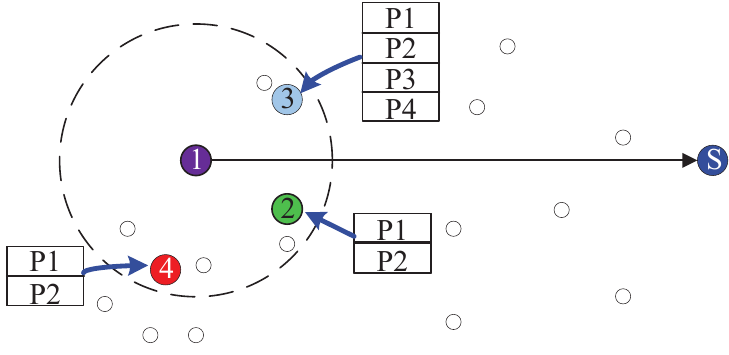
Figure 3. Relay selection